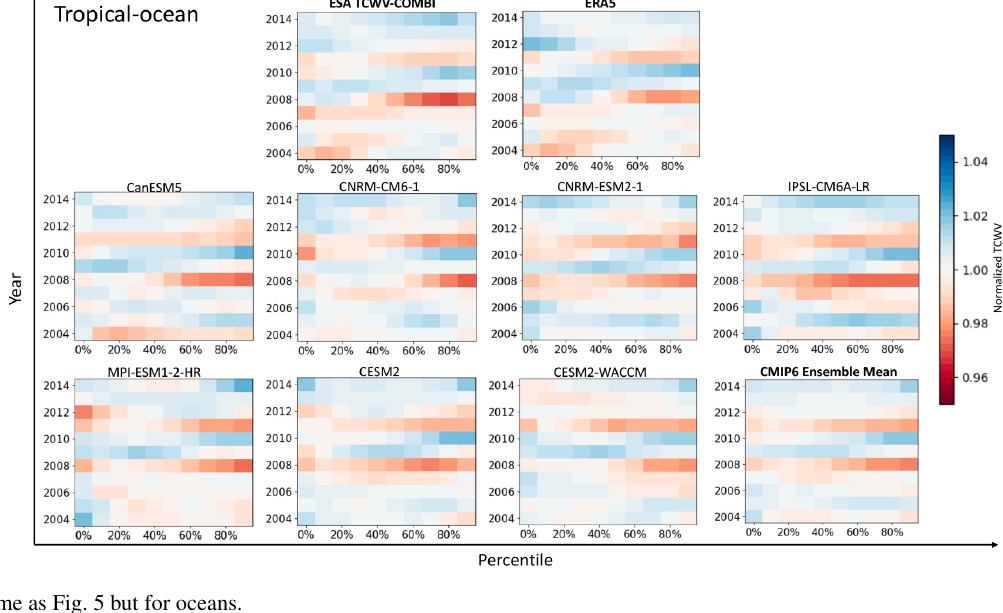
Figure 6. Same as Fig. 5 but for oceans.